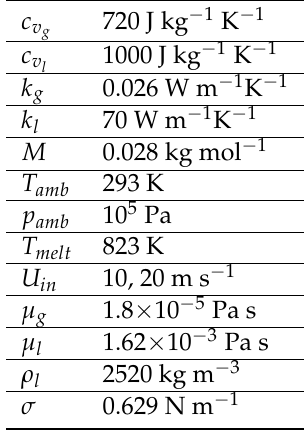
Table 2. Model parameters. The parameters for gas are those for air; those for metal are for the alloy AlSi9Cu3 [12,19,27].